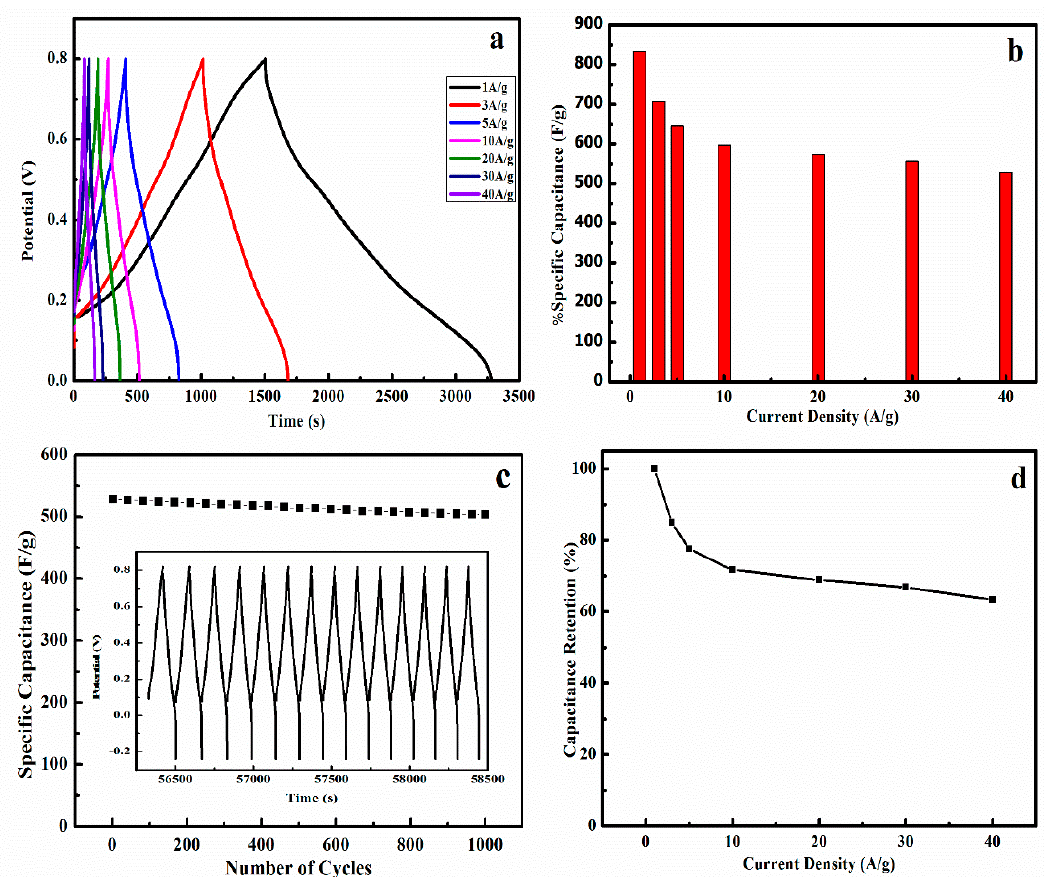
Figure 6. ( a ) GCD curves of P-5PA at current densities of 1, 3. 5, 10, 15, 20, 30 and 40 Ag − 1 ( b ) Histogram showing specific capacitance values of P-5PA at various current densities; ( c ) cycle stability of P-5PA over 1000 GCD cycles at 40 Ag − 1 while inset reflects few GCD cycles at 40 Ag − 1 current density; ( d ) percent capacitance retention of P-5PA against various current densities.